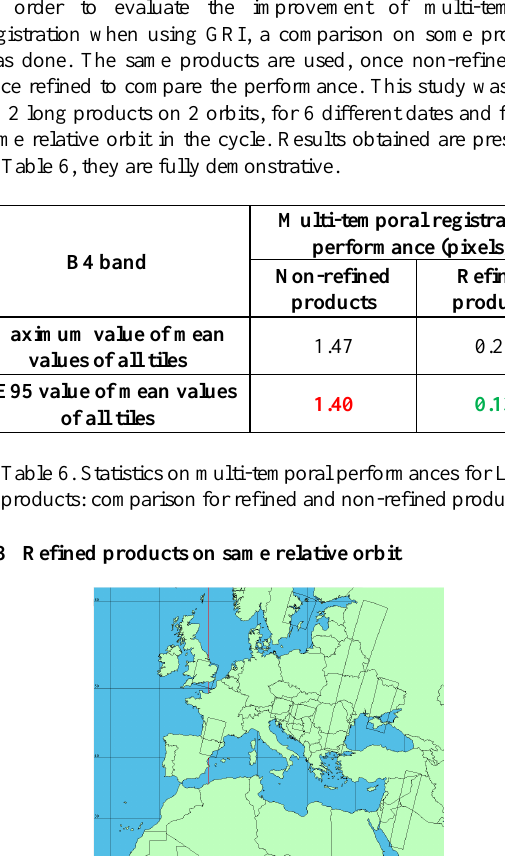
Table 7. Statistics on multi-temporal performances for refined L1C products on the same relative orbit.